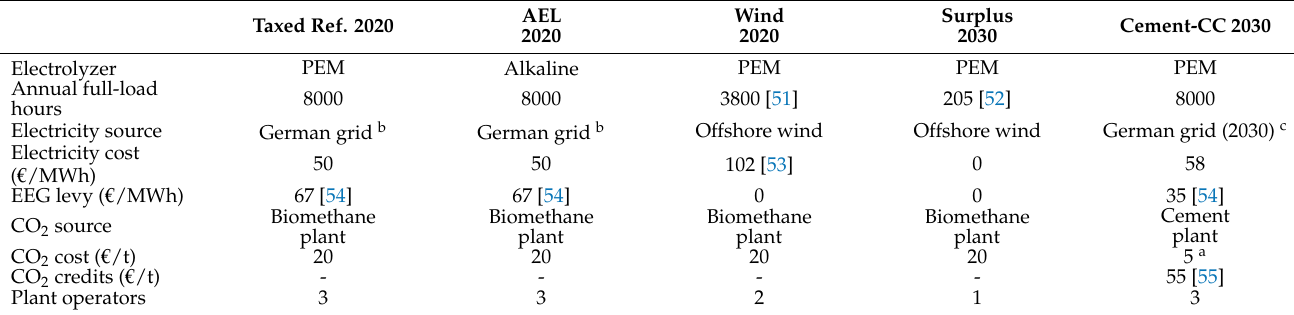
Table 5. Framework conditions for each